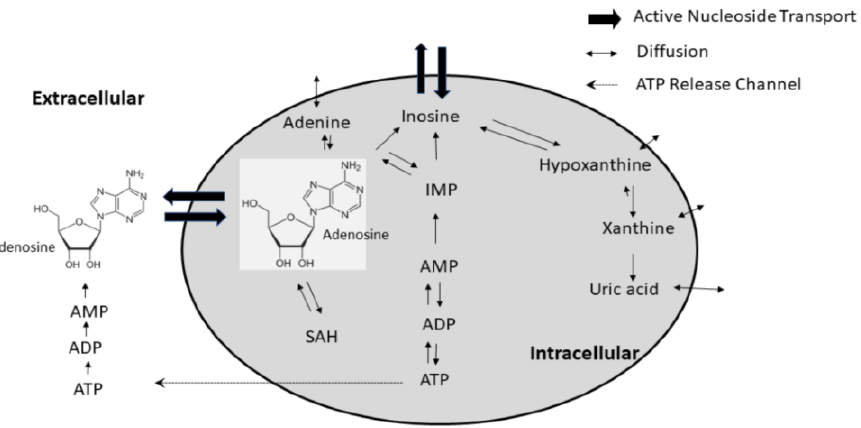
Figure 1. Complex ATP and adenosine metabolism. Abbreviation: SAH = S -adenosyl homocysteine.